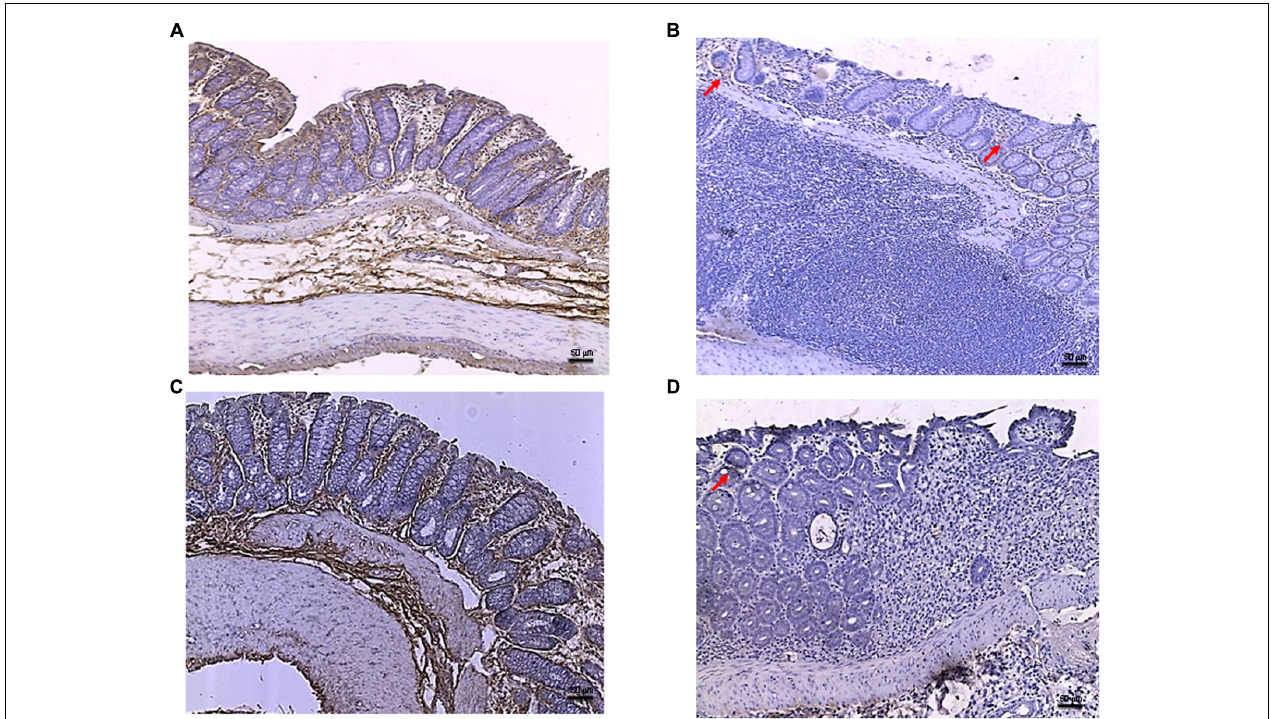
FIGURE 6 | Bcl-2 immunostaining from DNBS-treated animals. Representative Bcl-2 immunostaining (original magnification 10 × ) of tissues derived from control (A) , DNBS + drug vehicle (B) , DNBS + PDRN (C) , or DNBS + PDRN + DMPX (D) treated animals are depicted. The images in (A,C) demonstrate diffuse Bcl-2 staining, while the arrows in (B,D) point to the residual Bcl-2 staining in the mucosal layer. Scale bar 50 µ m.